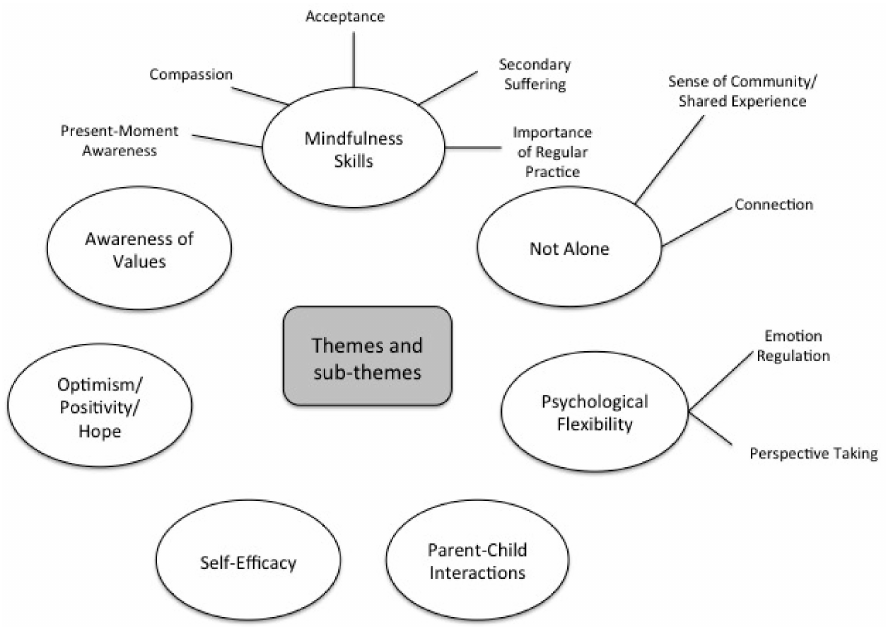
Figure 2. Themes and subthemes resulting from qualitative analysis of the post session